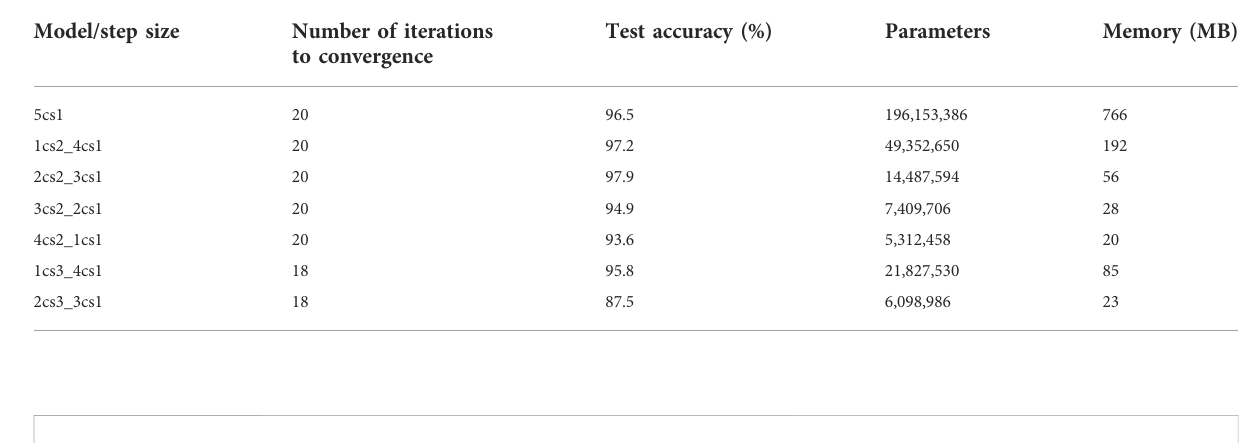
TABLE 2 In fl uence of step size on network performance.